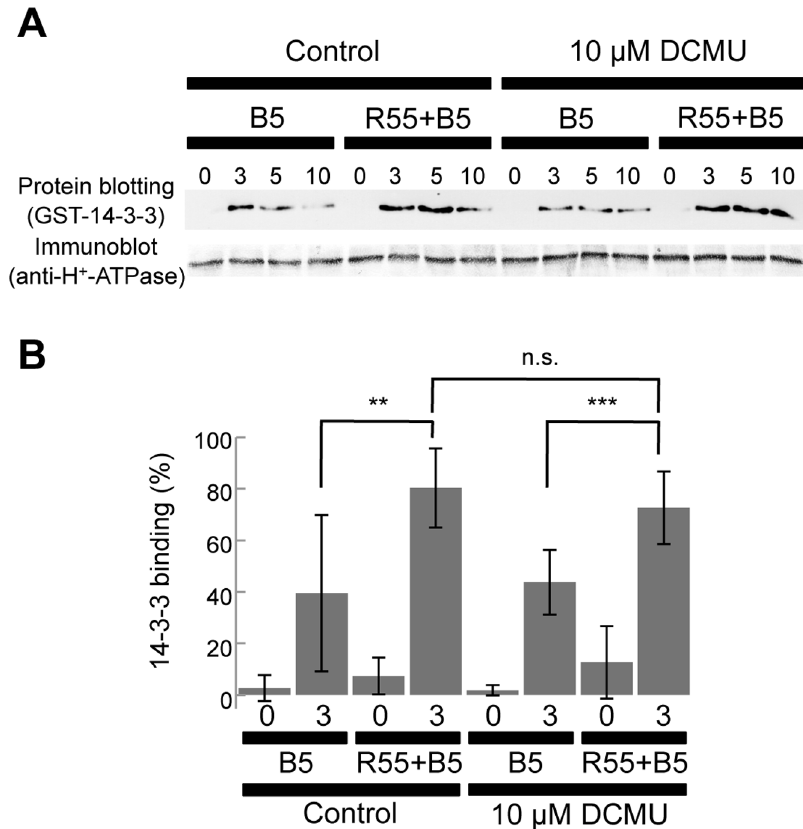
Figure 3. BL-induced phosphorylation of H + -ATPase in wild-type guard cell protoplasts. Guard cell protoplasts (60 m g protein) were irradiated with 5 m mol m 2 2 s 2 1 BL with or without 2 h pre-irradiation and background irradiation with 55 m mol m 2 2 s 2 1 RL (R55 + B5 and B5, respectively). DCMU (dissolved in DMSO) was administered before pre-irradiation with RL at 10 m M (0.01% DMSO). In samples collected at 0, 3, 5, and 10 min after BL exposure, the phosphorylation status of the H + -ATPase was determined by protein blotting with a 14-3-3 protein. Each lane contained 5 or 7 m g guard cell proteins for protein blotting (upper panels) and immunoblotting (lower panels). A, Representative example of similar results obtained in five independent experiments. B, Quantification of the binding of 14-3-3 proteins to the H + -ATPase. The 14-3-3 binding before or 3 min after BL exposure was determined. Values presented are means of five independent experiments with SDs. Asterisks indicate the statistically significant differences, assessed by Student’s t -tests (**: 0.01 , P , 0.05, ***: P , 0.01). n.s. indicates the statistically insignificant difference ( P .